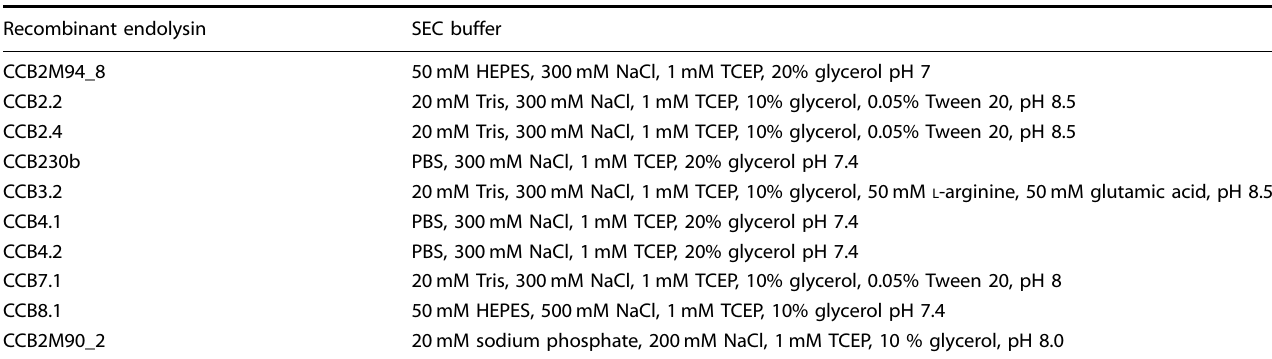
Table 2. Size exclusion chromatography buffers used for the different endolysins.